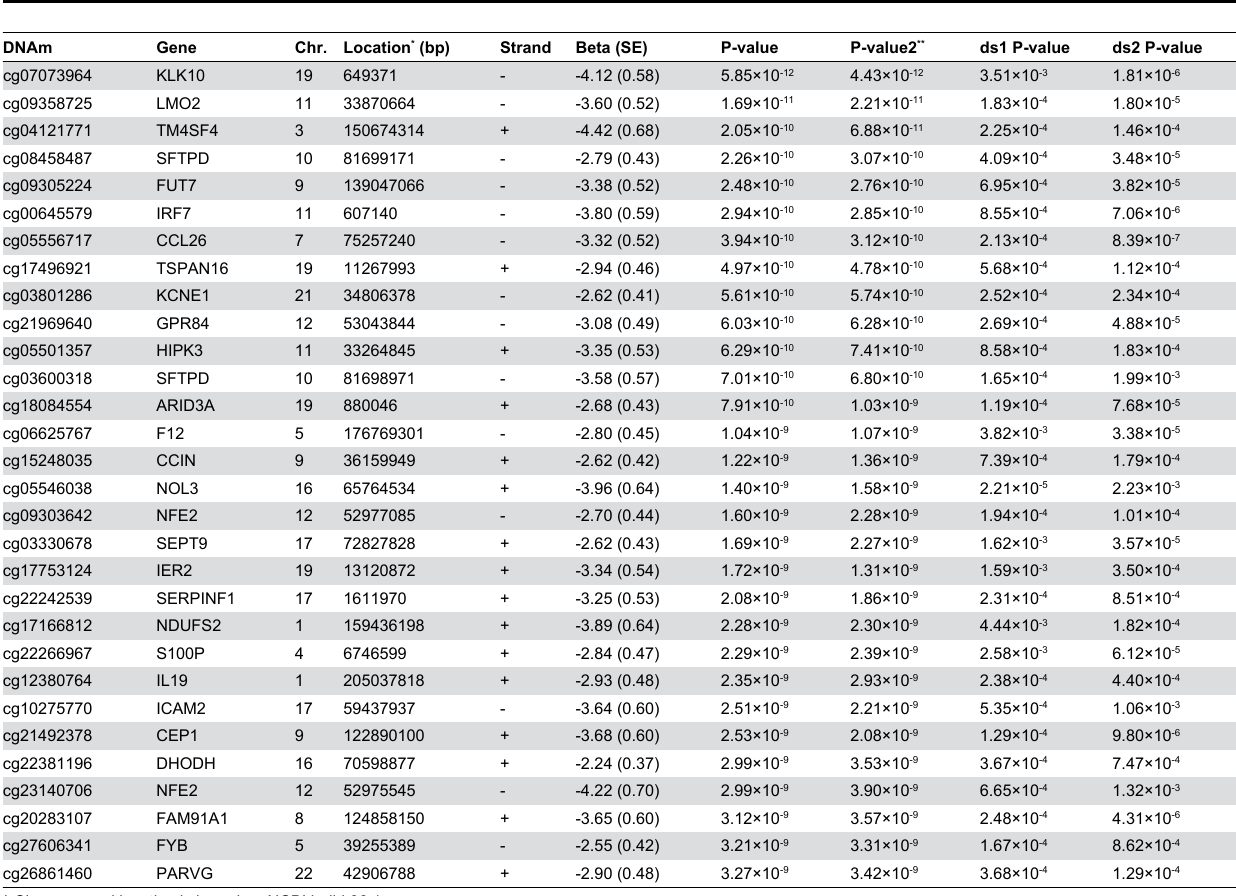
Table 2. Summary of the 30 most significant CRP-associated DNA methylation sites.